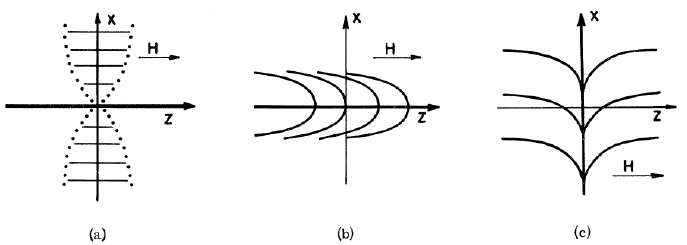
Figure 1. Schematic diagrams of different alignment inversion walls. ( a ) Twist wall. ( b ) Splay-bend wall parallel to the magnetic field. ( c ) Splay-bend wall vertical to the magnetic field. Reprinted with permission from Ref. [15]. Copyright 1968 American Physical Society.